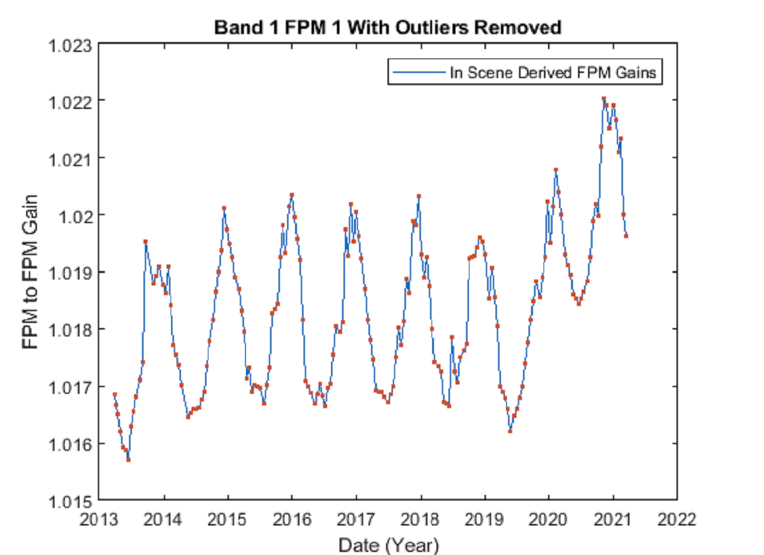
Figure 9. In-scene FPM relative gain for Band 1 FPM 1 across all Arabian Desert scenes throughout Landsat 8’s